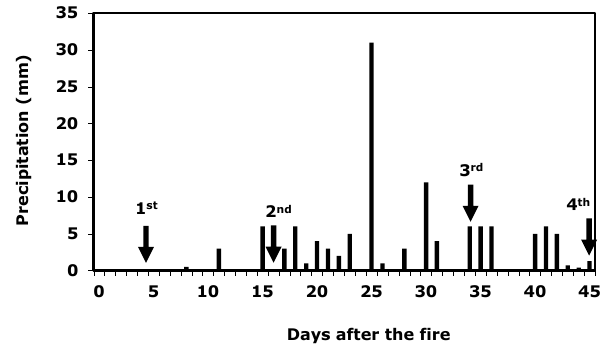
Fig. 1. Daily precipitation throughout the study period. Arrows point to days when measurements were collected and the numbers above the arrows indicate the measurement period.